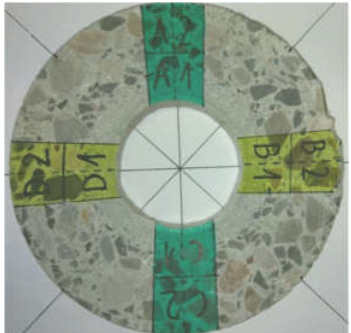
Figure 3. About 10 mm slice cut out of principal sample. Division of slice into smaller samples for tests proper is shown.